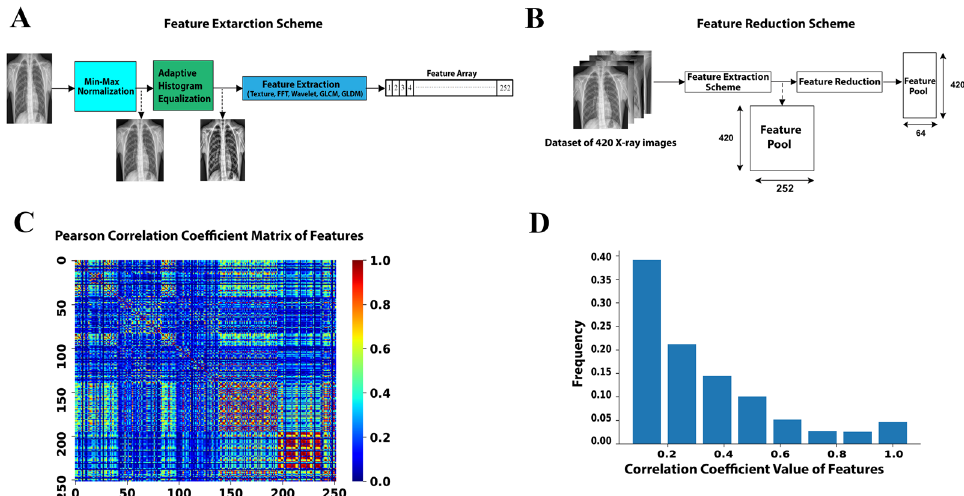
Figure 1. (A) Feature extraction schematic diagram to build a feature array for each CXR image using the Texture, FFT, Wavelet, GLCM, and GLDM methods (See method section for the description of the features). (B) A schematic diagram of creating a feature pool for 420 CXR images and applying a feature reduction method. (C,D) Correlation analysis of features. The heat map (C) and histogram representation (D) of the Pearson correlation